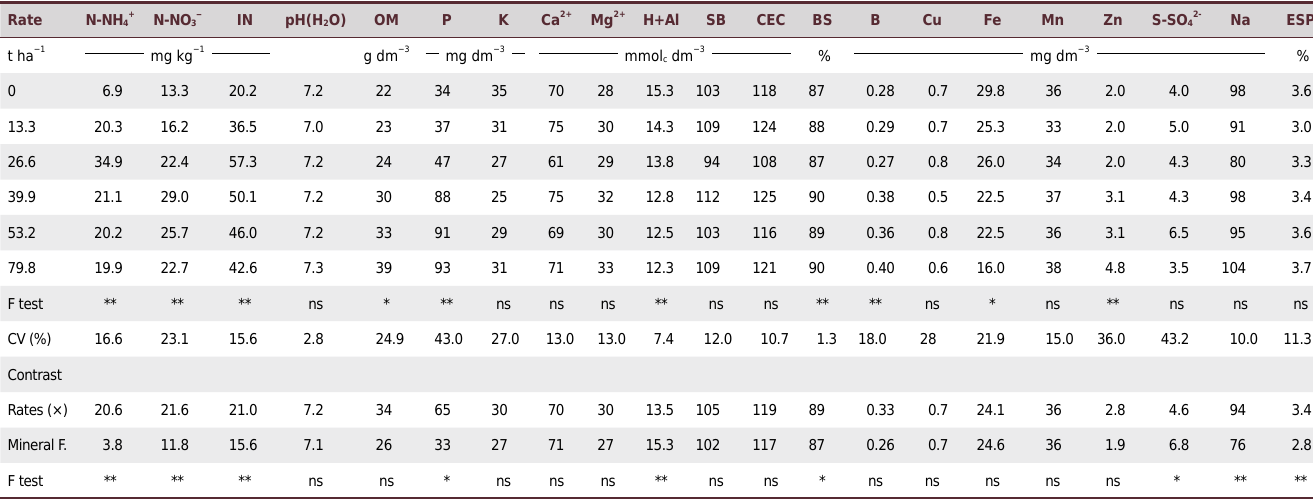
Table 3. Mean values, F test, and coefficient of variation for the soil chemical properties in the 0.00-0.20 m layer in response to organic compost rates applied to elephant grass Rate N-NH 4+ N-NO 3 ‒ IN